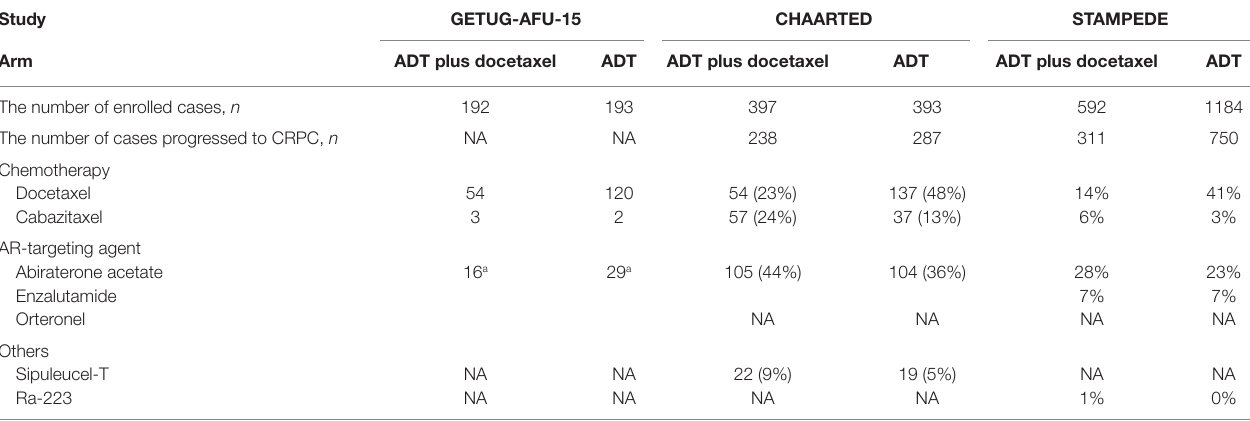
TABLe 1 | Subsequent active therapy after progression to